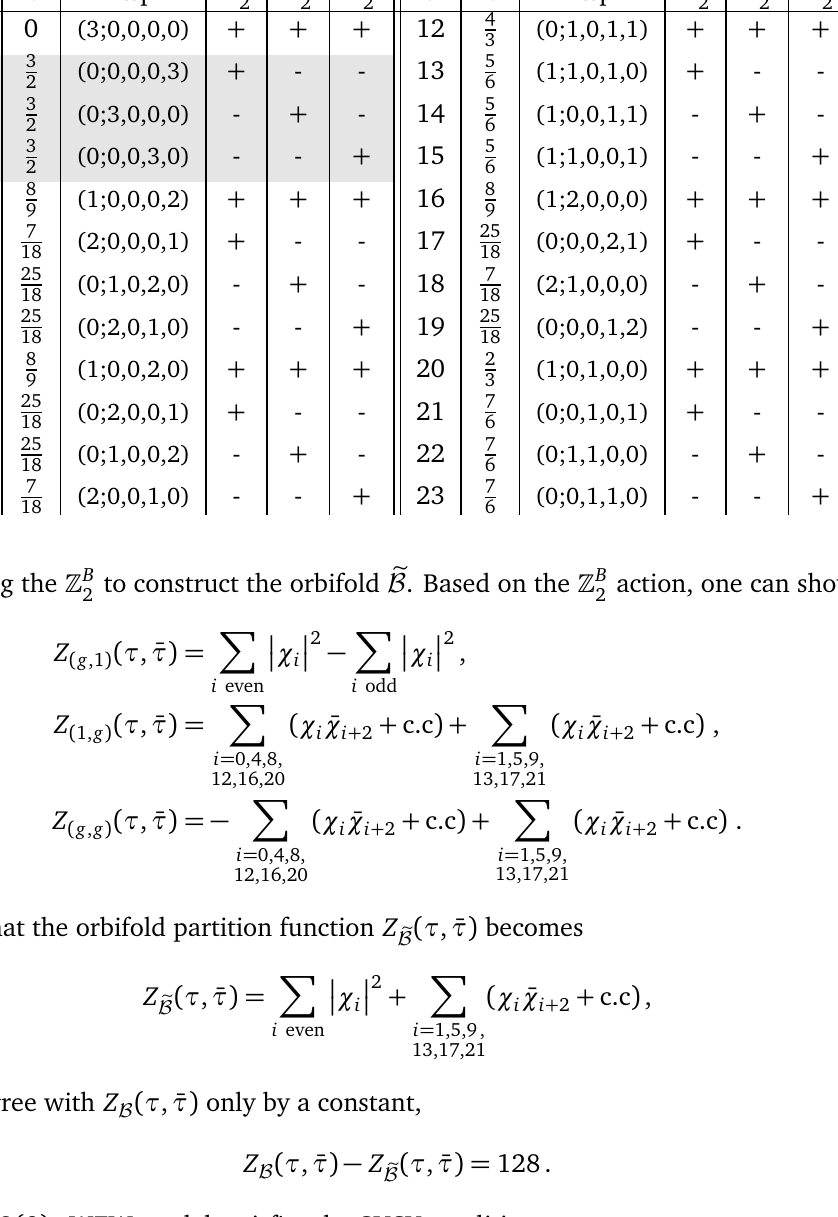
( τ ) . Primaries i = 1,2,3 are the generator of (cid:90) A i